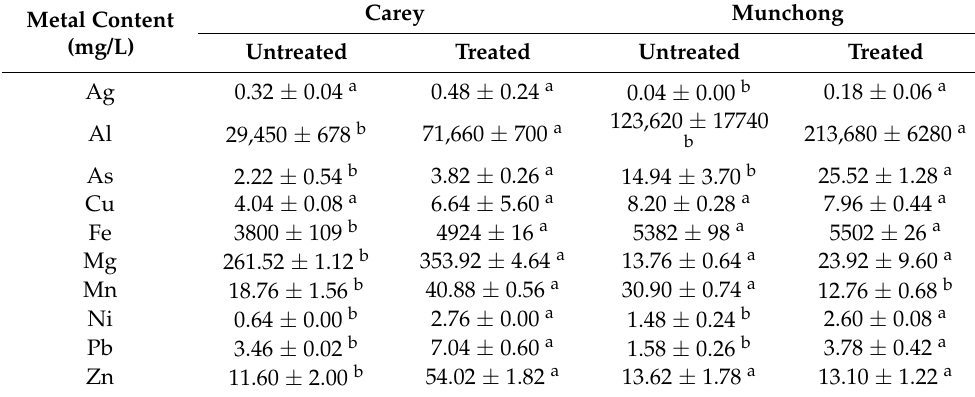
Table 7. Total metal content in untreated and treated Carey and Munchong solid samples.